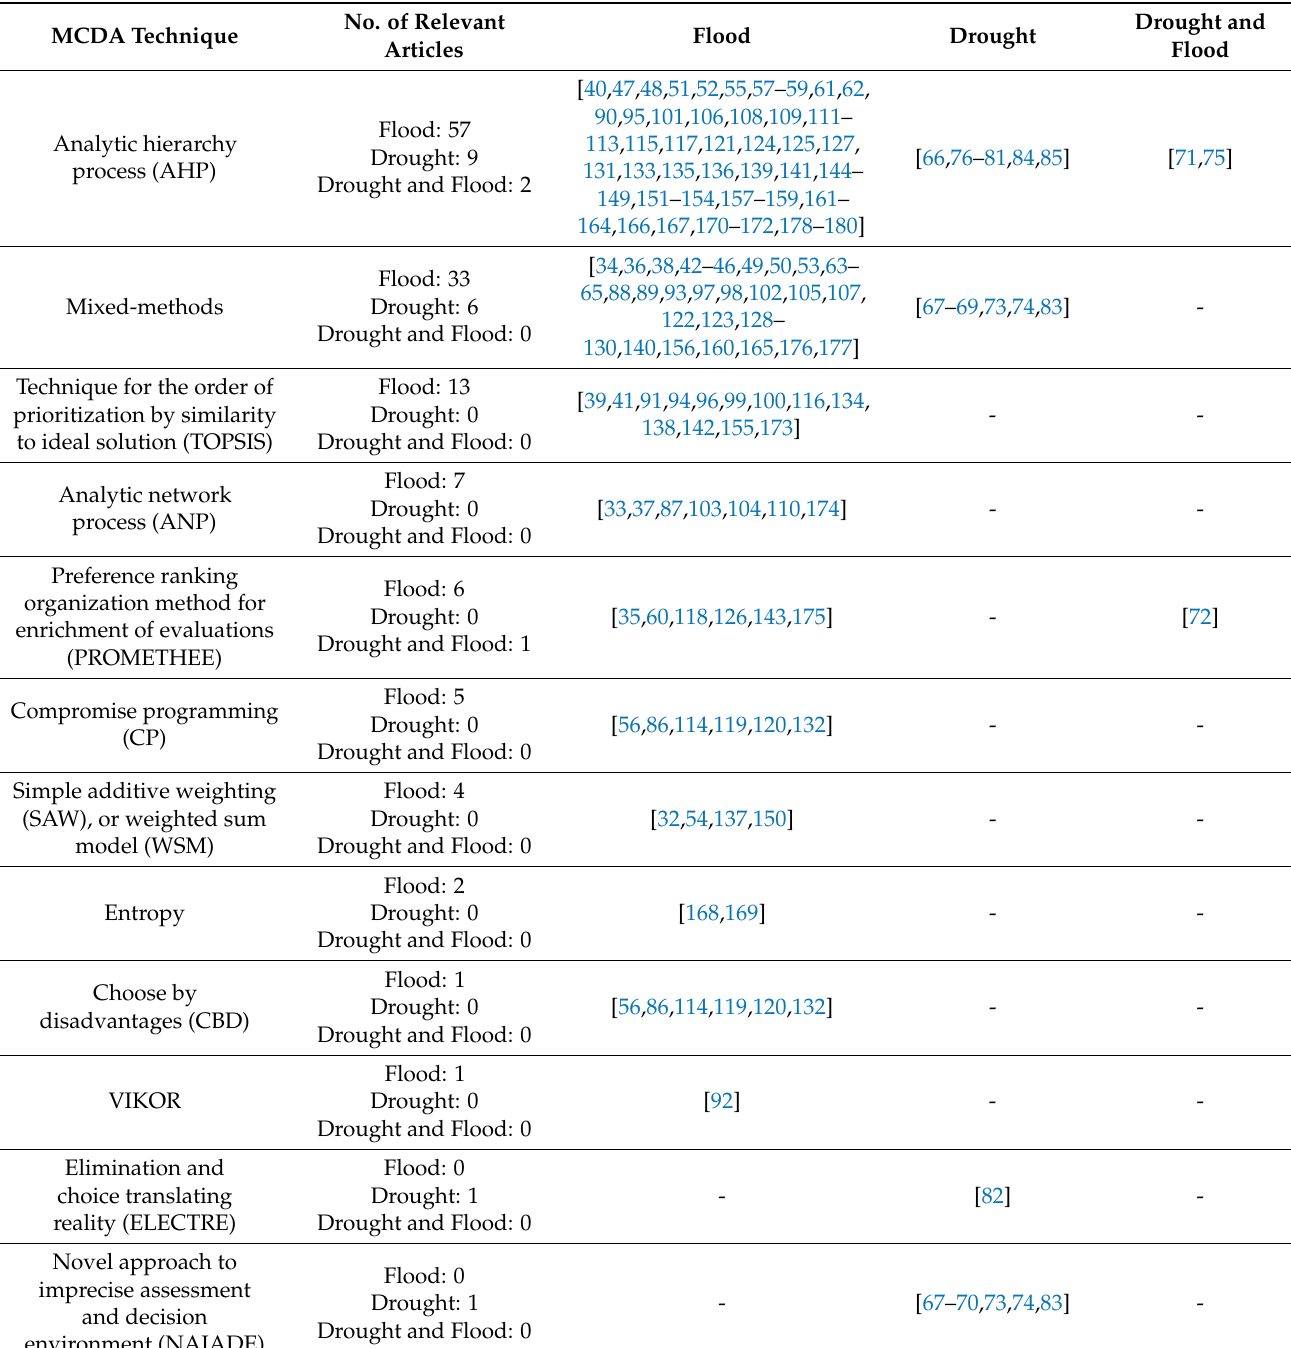
Table 8. Classification of MCDA techniques based on WRD